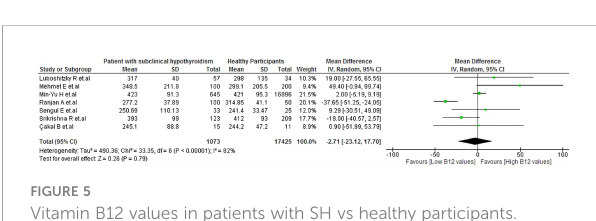
FIGURE 5 Vitamin B12 values in patients with SH vs healthy participants.